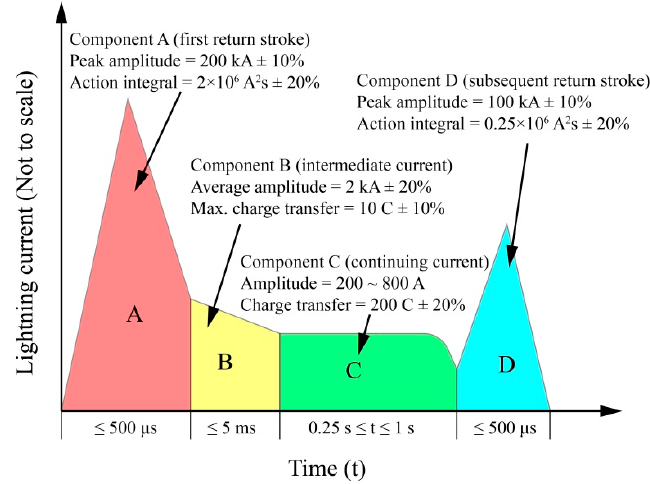
Figure 2. Simulated lightning current waveforms in [23].